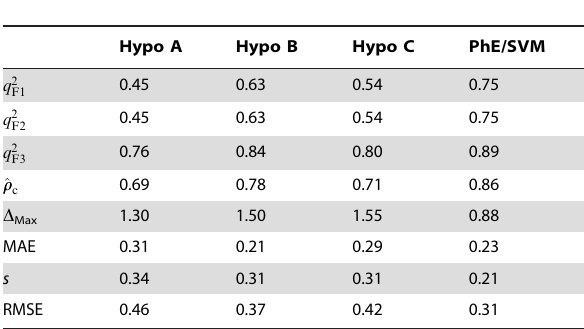
Table 2. Statistic parameters correlation coefficients q 2 and q 2 , concordance correlation coefficient ( ^ rr F3